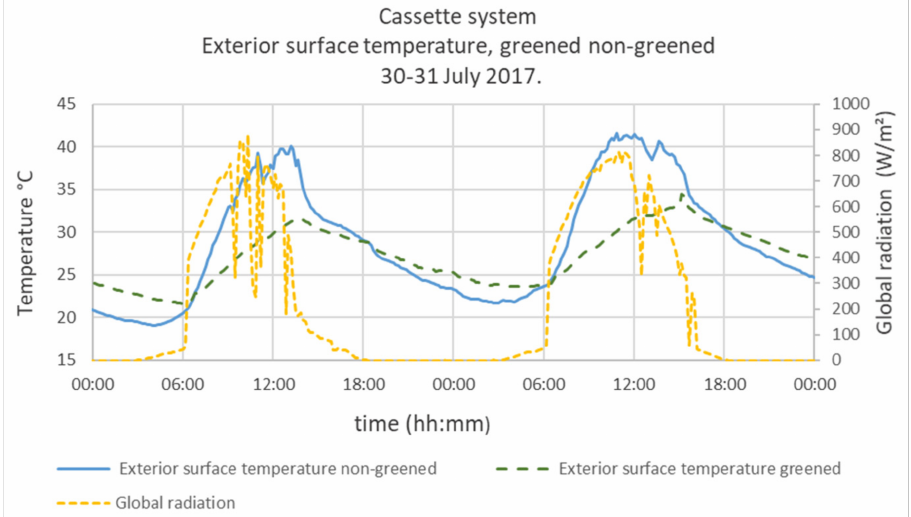
Figure 10. Cassette system, exterior surface temperature, greened and non-greened, 30–31 July 2017. The surface temperature of the non-greened wall is significantly higher than the wall shaded with the greening system. The value of the maximum differences of both